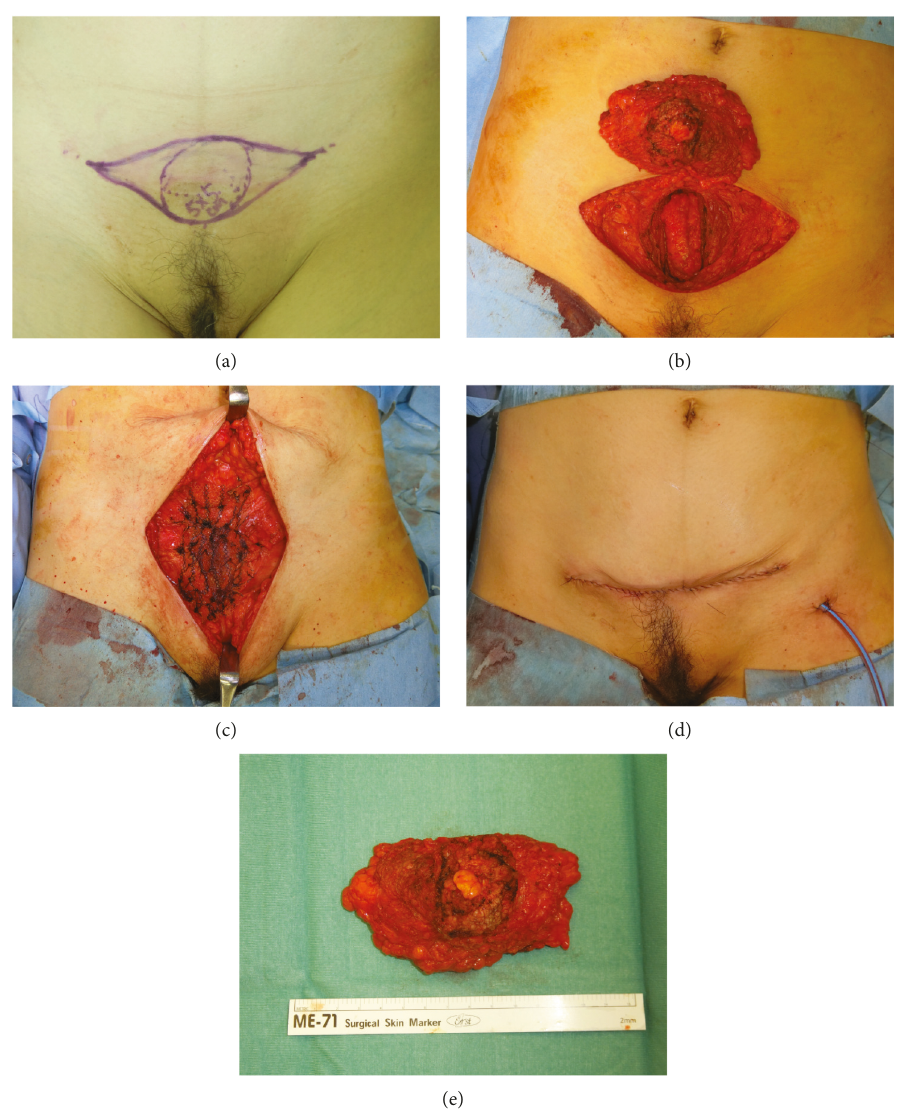
Figure 3: Intraoperative findings. (a) Preoperative design. (b) After tumor resection. (c) Abdominal wall reconstruction using a mesh. (d) Wound closure. (e) Removed specimen.